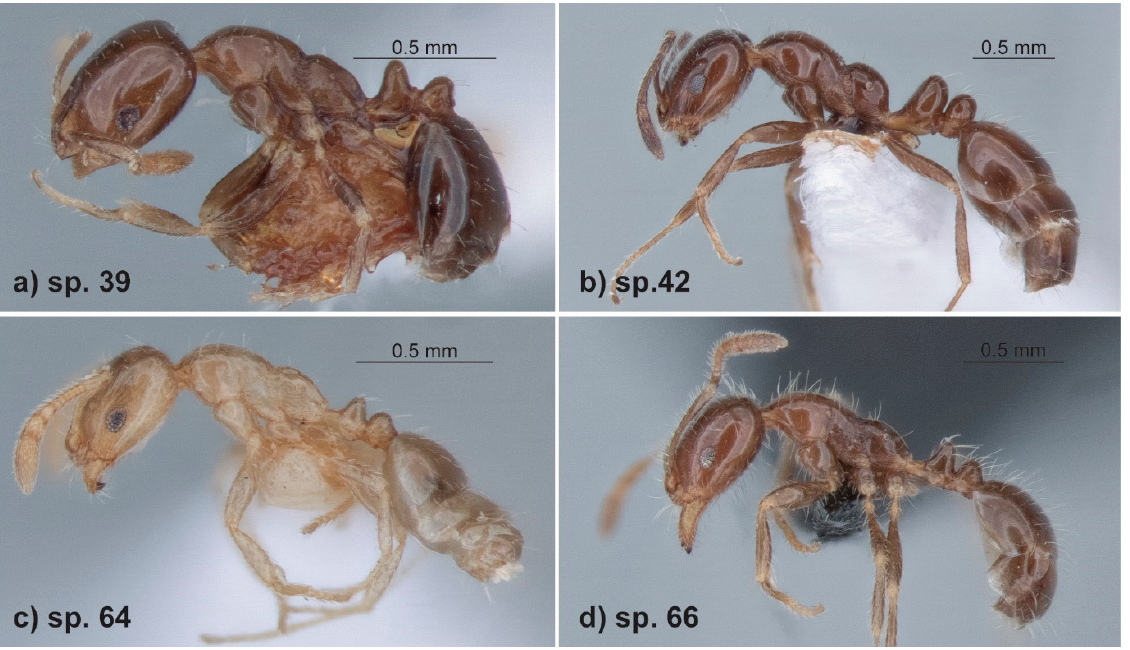
Figure 11. Additional species known from the Top End of the NT (not sequenced in this study). The species belong to the ‘sp. 14’ ( a ), ‘ fieldi ’ ( b ), ‘sp. 9’ ( c ) and ‘ donisthorpei ’ ( d ) morphotypes. Species codes follow [8].